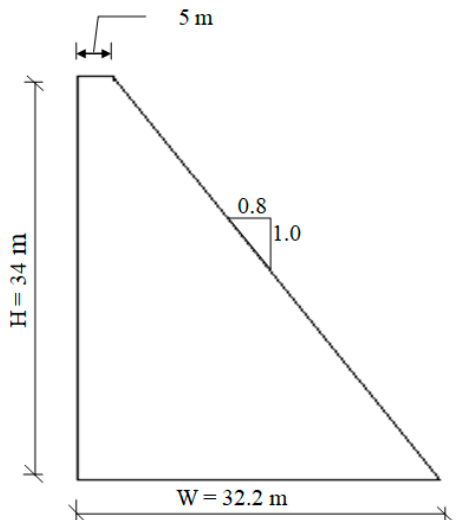
Figure 1. Al- Khanaq roller compacted concrete (RCC) dam cross-section.